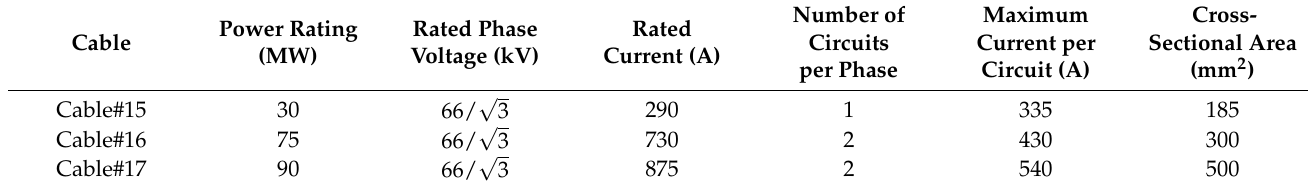
Table A9. AC-cables design for Architecture 4.